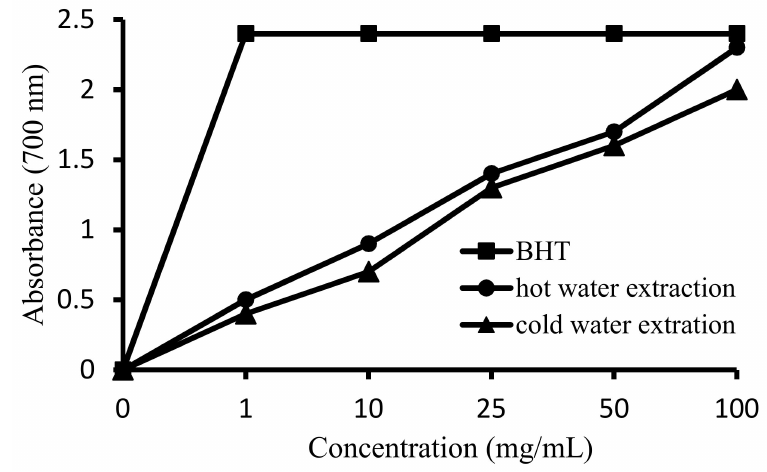
Figure 3. Reducing power of the butterfly pea flower